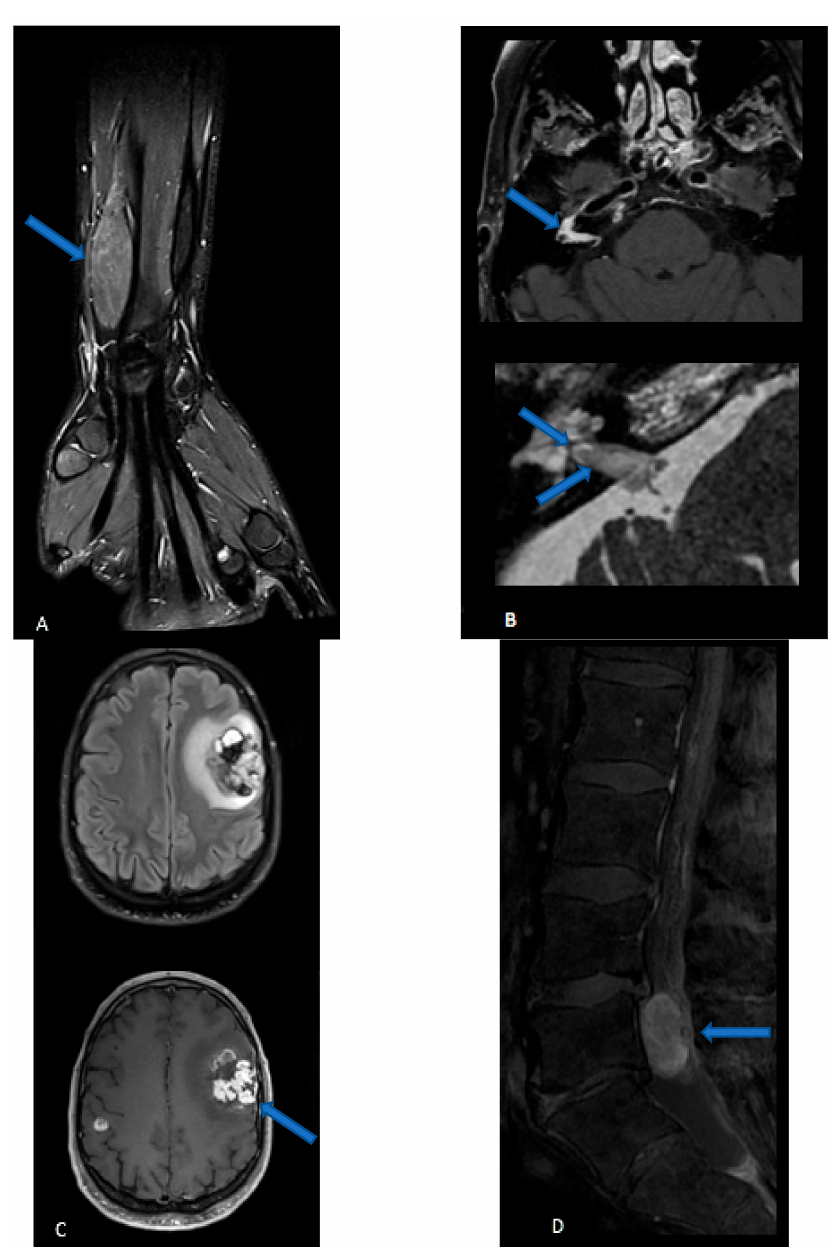
Figure 1. ( A ) Perineurioma: coronal three-dimensional (3D) proton density sequence of the wrist after fat suppression displays a fusiform enlargement of the radial nerve. ( B ) Malignant peripheral nerve sheath tumor: Three-dimensional T1-weighted spin echo sequence after contrast injection and fat suppression (upper image) shows a contrast-enhanced lesion in the right internal auditory canal and geniculate ganglion. High-resolution 3D T2-weighted sequence (lower image) reveals intra-cochlear extension of the tissue mass. ( C ) Malignant intracerebral nerve sheath tumor: 3D FLAIR sequence in the axial plane (upper image) and 3D T1-weighted spin echo sequence after contrast injection shows two intra-axials, enhancing lesions. The biggest lesion, located in the left superior frontal region, is highly heterogeneous, with hemorrhagic and cystic components, and is surrounded by FLAIR hyperintensity. The second, smaller lesion of the right hemisphere is hardly visible on the FLAIR image while it strongly enhances after contrast administration. ( D ) Cauda equine neuroendocrine tumor: sagittal T1-weighted sequence after contrast injection and fat suppression of the lumbar spine displays a well-defined intradural extramedullary contrast, enhancing